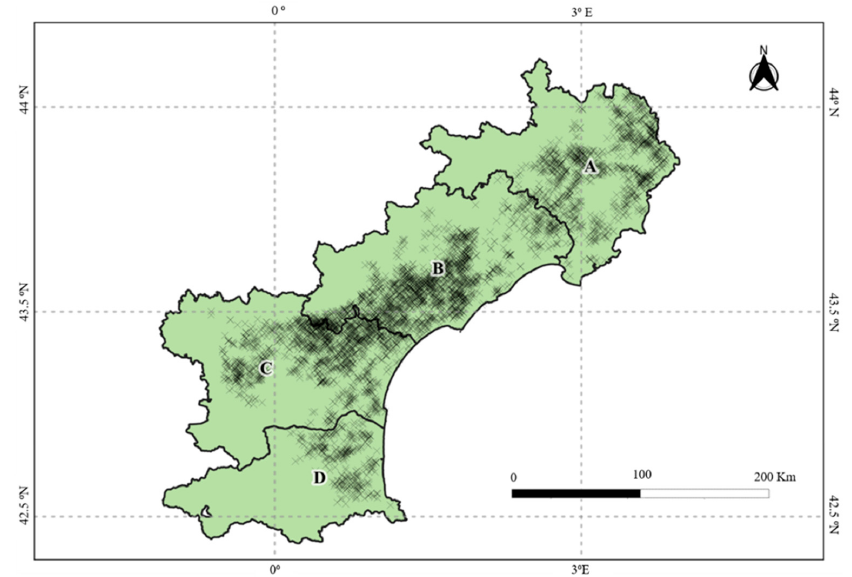
Figure 6. Location of vineyard blocks (4978) of interest in Southern France.